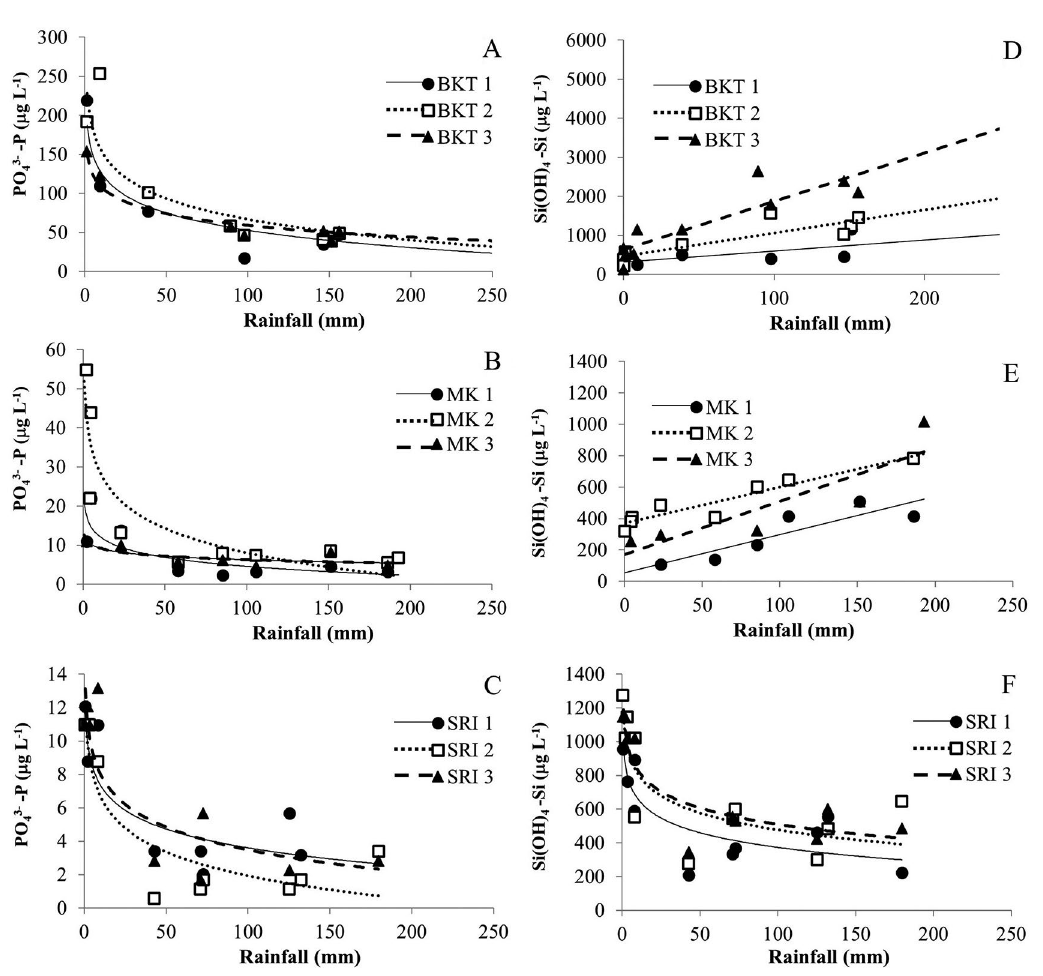
Fig. 5. – Correlation between rainfall and phosphate-phosphorus (PO 43– -P) (A, B and C), and correlation between rainfall and silicate-silicon (Si(OH) -Si) (D, E, and F) at each sampling station in the pond area of Bang Khun Tien (BKT), the estuary area of the Maeklong river mouth 4 (MK) and the coastal area of Sriracha (SRI) based on monthly measurements from January to December